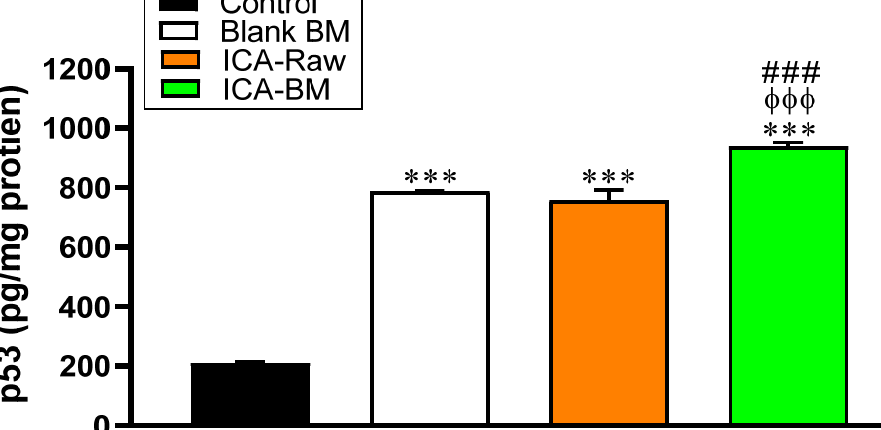
Figure 8. Effect of Blank BM, ICA-Raw, and ICA-BM treatments on p53 content in PANC1 cells. Data are the mean of 4 independent experiments ± SD. *** Significantly different vs. Control ( p < 0.001); φφφ Significantly different vs. Blank BM ( p < 0.001); ### Significantly different vs. ICA-Raw ( p < 0.001).